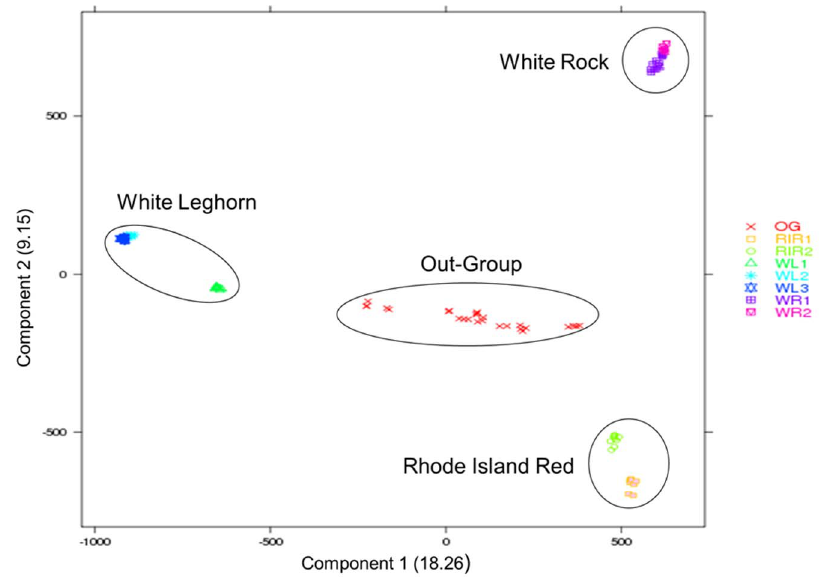
Figure 1. PCA analysis for all the 96 individuals with 1 million SNPs. doi:10.1371/journal.pone.0094509.g001 PLOS ONE |